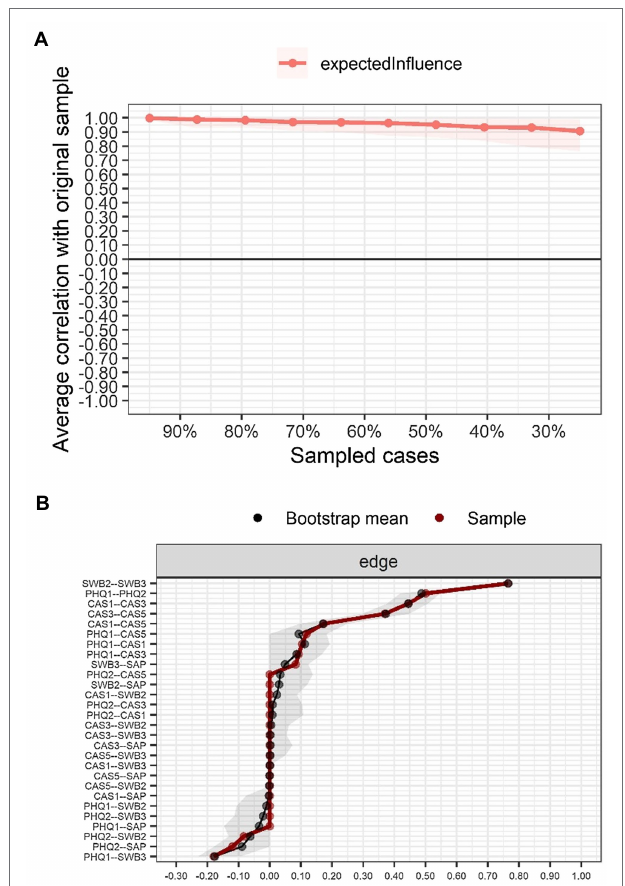
FIGURE 2 | Stability and accuracy of the network. (A) Stability of the EI centrality index; (B) Accuracy through the non-parametric bootstrap confidence intervals (95%) of edges estimated for the